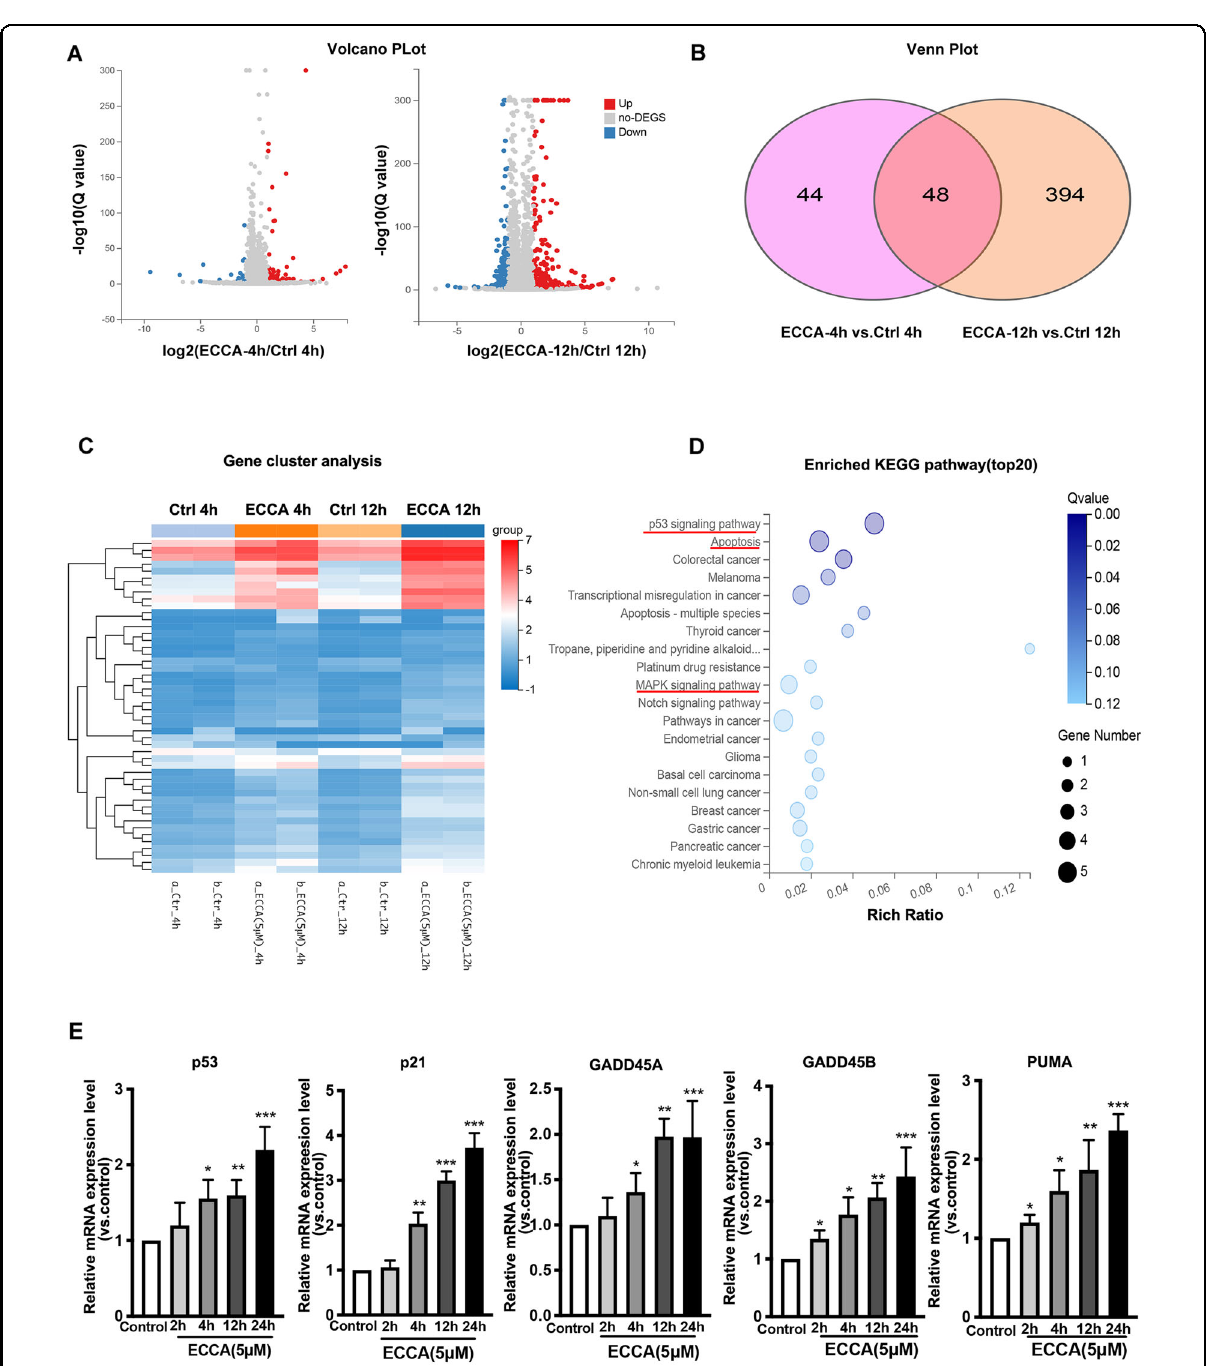
Fig. 4 RNA-seq analysis of the effect of ECCA on the gene expression pro fi le of UACC62 cells. A Volcano plot visualizing DEGs between the ECCA group and the control group at 4 h and at 12 h. The p value <0.001 was used as a threshold to determine the signi fi cance of DEGs. Red dots represent upregulated DEGs, blue dots represent downregulated DEGs, and gray dots indicate transcripts that did not change signi fi cantly between the two groups. B Venn plot presenting the number of DEGs between the ECCA-treated group and the control group at 4 h and at 12 h. C Gene cluster analysis of 48 common DEGs was conducted based on the FPKM value of each sample. The X axis represents the different samples, whereas the Y axis represents DEGs. The color (from blue to red) represents DEG expression intensities from low to high. D KEGG pathway enrichment of DEGs. The X axis shows the enrichment factor; the left Y axis shows the top 20 positive KEGG pathway names. The darker the color represents the smaller the q value. Bubble size indicates DEG number. E Relative expression levels of mRNAs (p53, p21, GADD45A, GADD45B, and PUMA) normalized by the human 36 β 4 gene, in UACC62 cells treated with or without 5 µM ECCA at 2, 4, 6, 12 h by RT-PCR analysis. All experiments were carried out three times and error bars represent means + SD; P values are indicated with “ * ” , * indicates P < 0.05, ** indicates P < 0.01, *** indicates P < 0.005 when comparing the ECCA-treated group with the control group in E by Student ’ s t